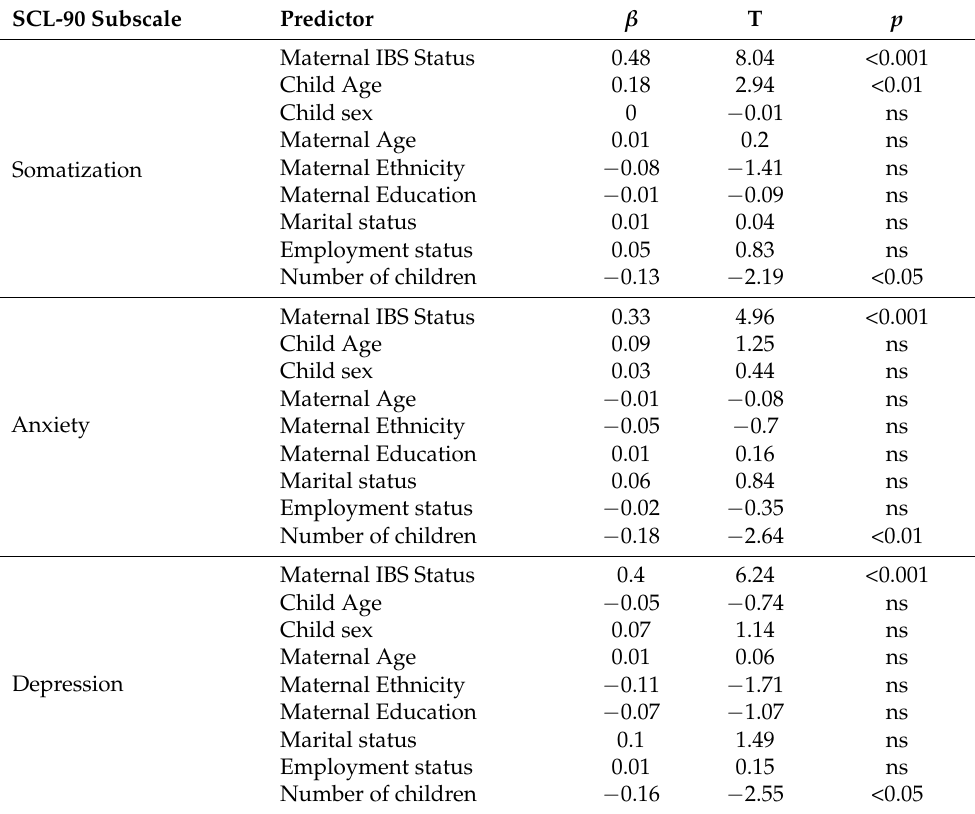
Table 5. Multiple regression predicting SCL-90